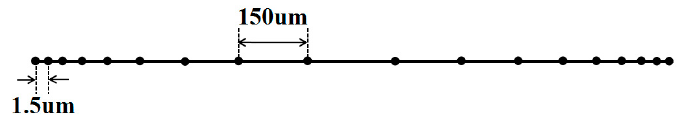
Figure 2. Mesh element distribution in a one-dimensional solution domain.